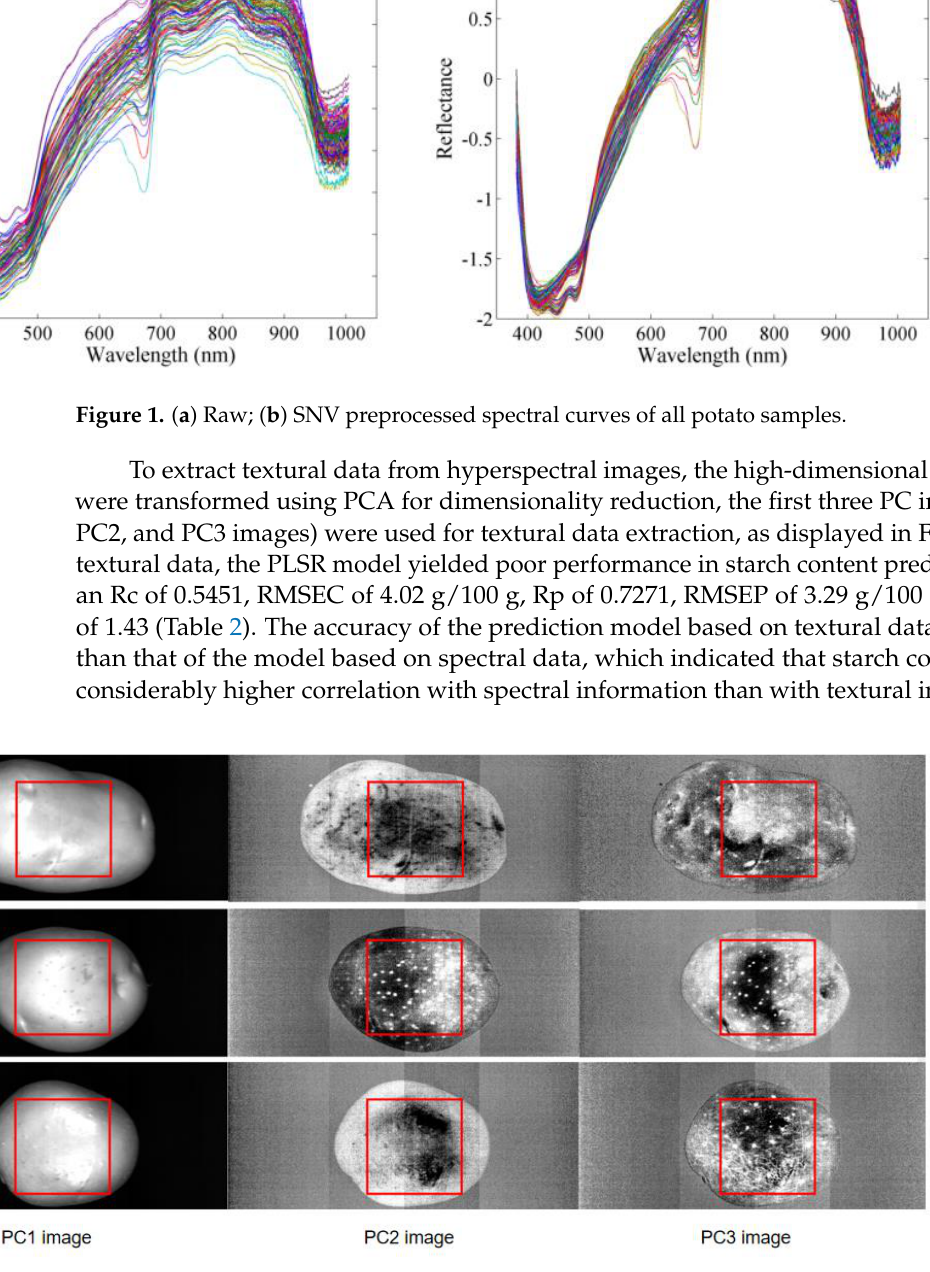
Table 2. Performance of PLSR models for starch content prediction by using different data.